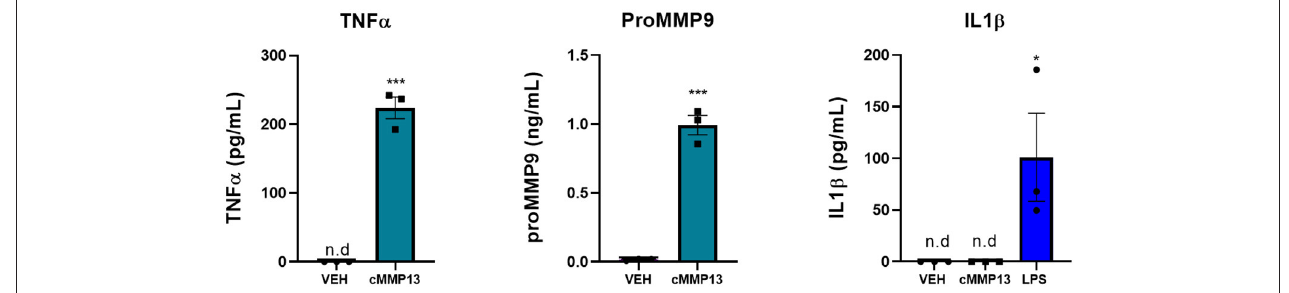
FIGURE 8 | The expression of a subset of microglia-derived proinflammatory molecules is increased following cMMP13 treatment. ELISAs were performed on microglia-conditioned media after cMMP13 or VEH exposure. Microglia treated with 20nM cMMP13 for 24h increased the release of TNF α and MMP9, but not IL1 β